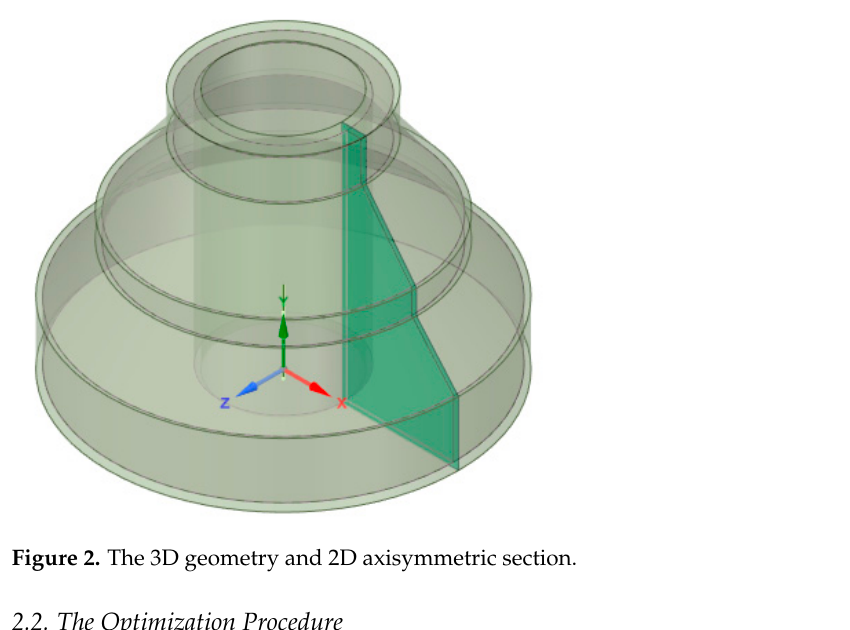
Figure 3. ( a ) The dimensions of the desired geometry and ( b ) the input optimized parameters.